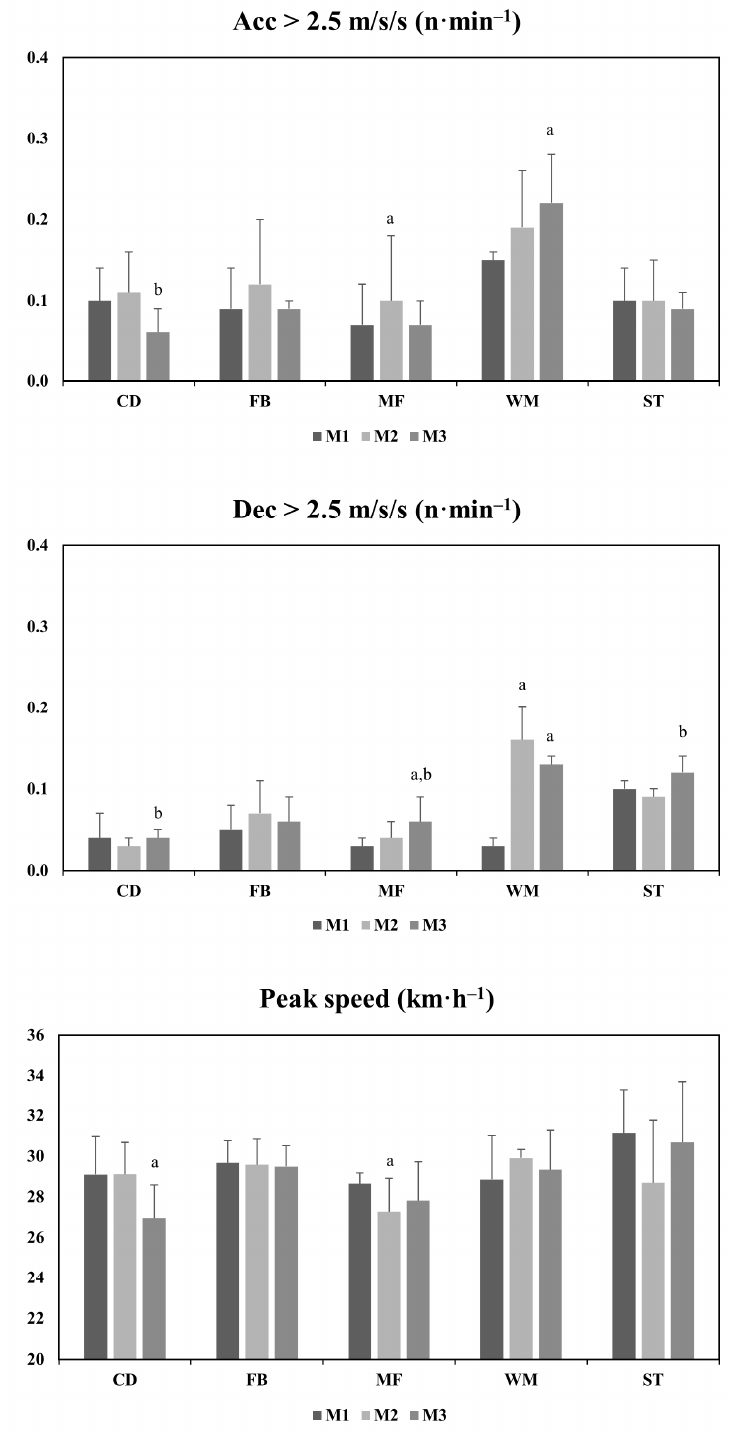
Figure 3. Comparison of accelerations, decelerations and peak speed during the three matches in a congested fixture. Acc = Accelerations; Dec = Decelerations; CD = Central Defenders; FB = Fullbacks; MF = Midfielders; WM = Wide Midfielders; ST = Strikers; a = significant difference with M1; b = significant difference with M2.